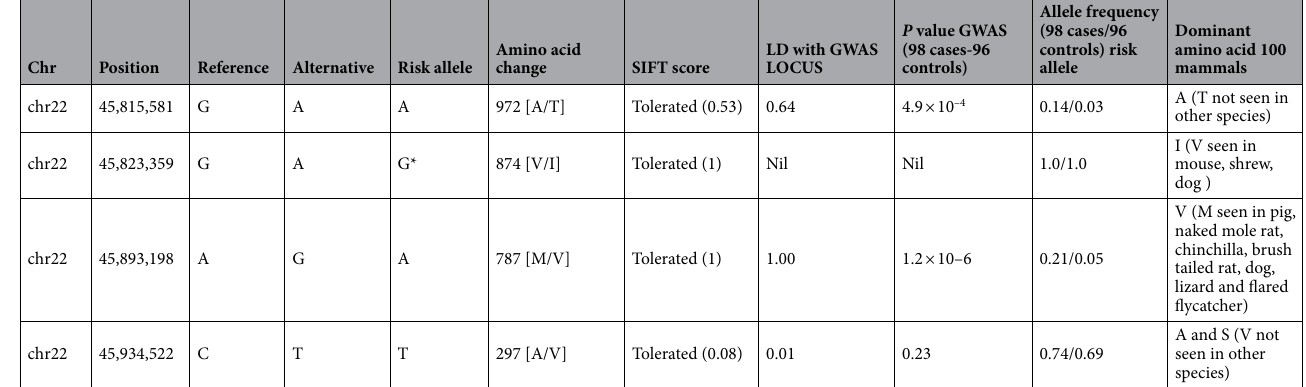
Table 2. Fine-mapped SNPs with potential function in the chr22 region. The four missense SNPs in the ABCC4 gene are displayed. They were identified in the 45–46 MB region of chromosome 22 based on next generation sequencing. The reference, risk and protective allele for each SNP is listed as well as the associated p-values for the SNPs when incorporated into the GWAS data set for 98 cases and 96 controls. The r 2 value is listed in relation to LD calculations between the most associated GWAS SNP on chromosome 22 and each of the coding SNPs. An evaluation of the most common amino acid residues for the ABCC4 coding changes based on the UCSC genome browser is also noted. *Only one dog (control) in the extended dataset with 292 dogs was heterozygous for the chr22:45,823,359